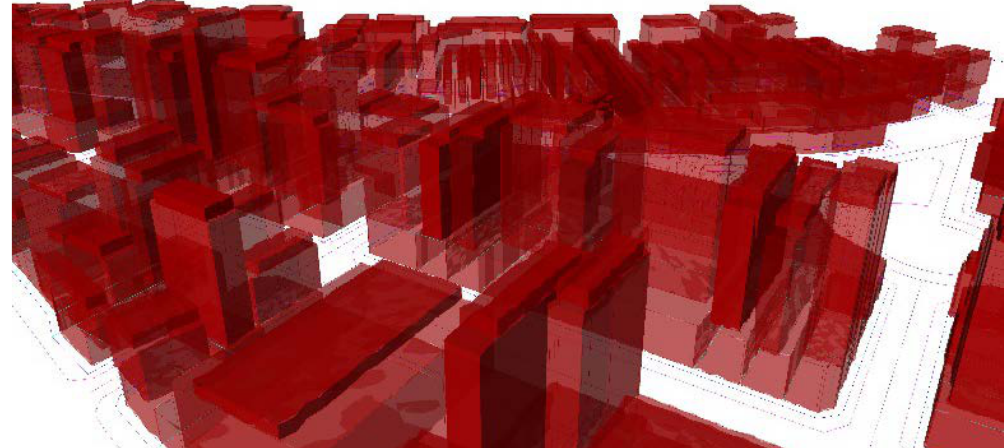
Figure 6. Simulation of the city (Aanches,